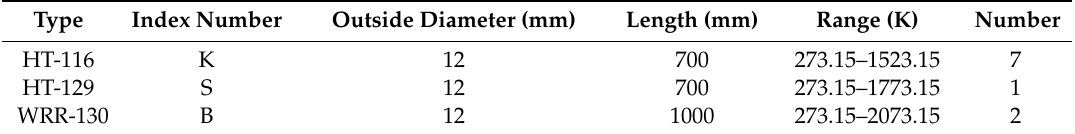
Table 5. Parameters of thermocouples.